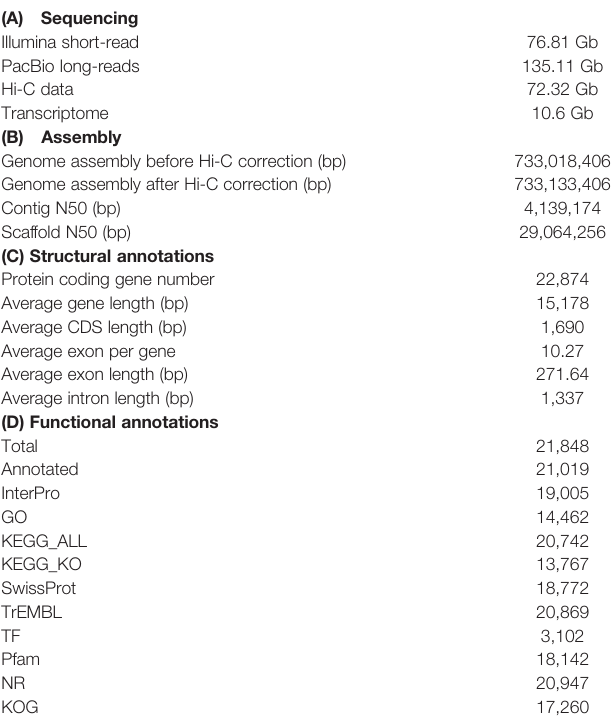
TABLE 1 | Sequencing for annotation of the H. agrammus draft genome. (A) Sequencing Illumina